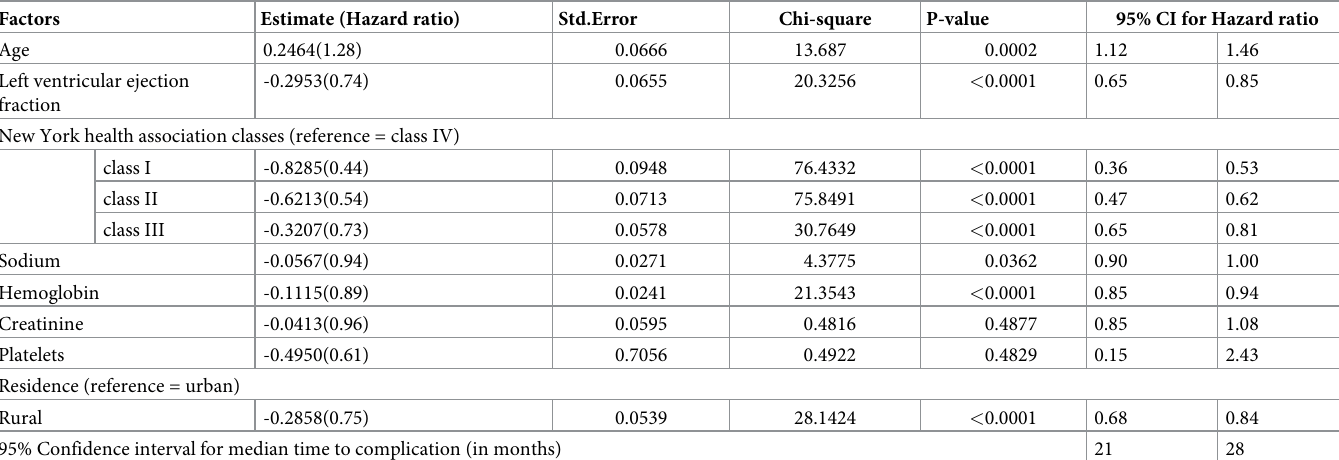
Table 6. Result from the fitted Cox PH